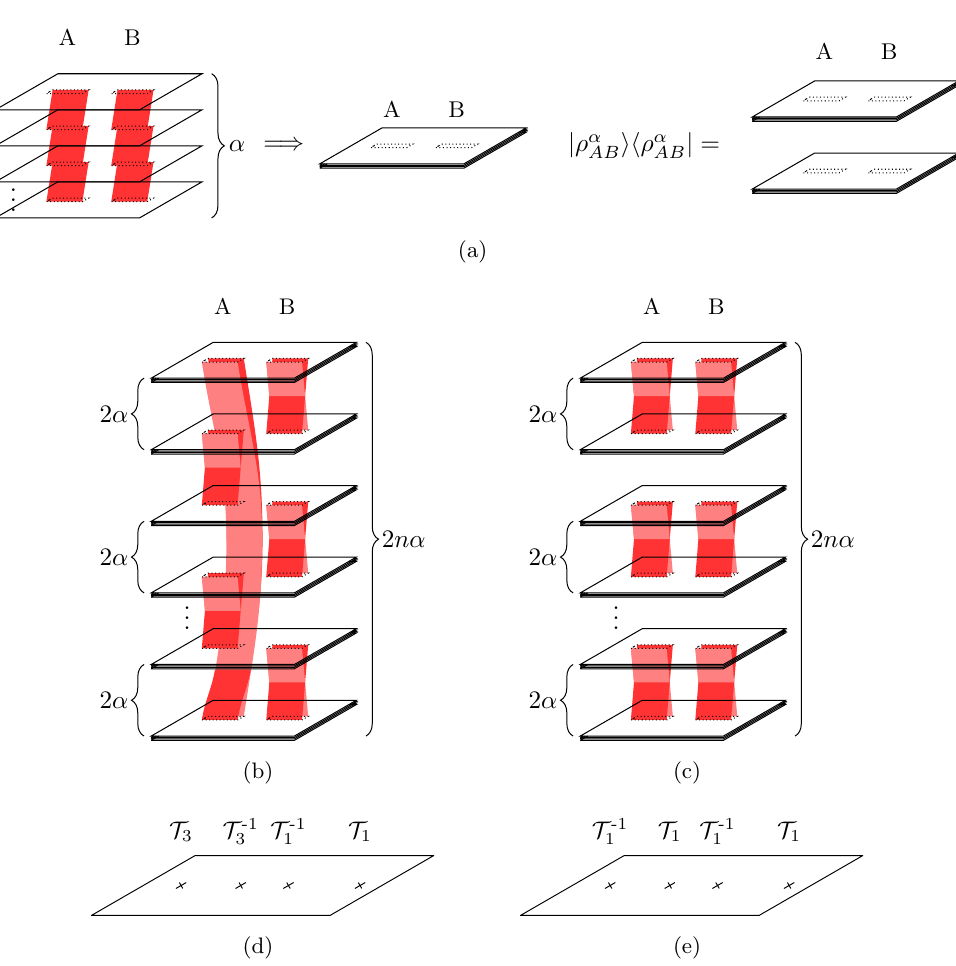
(cid:26) (cid:11) ( t ) (left) and the operator density j i